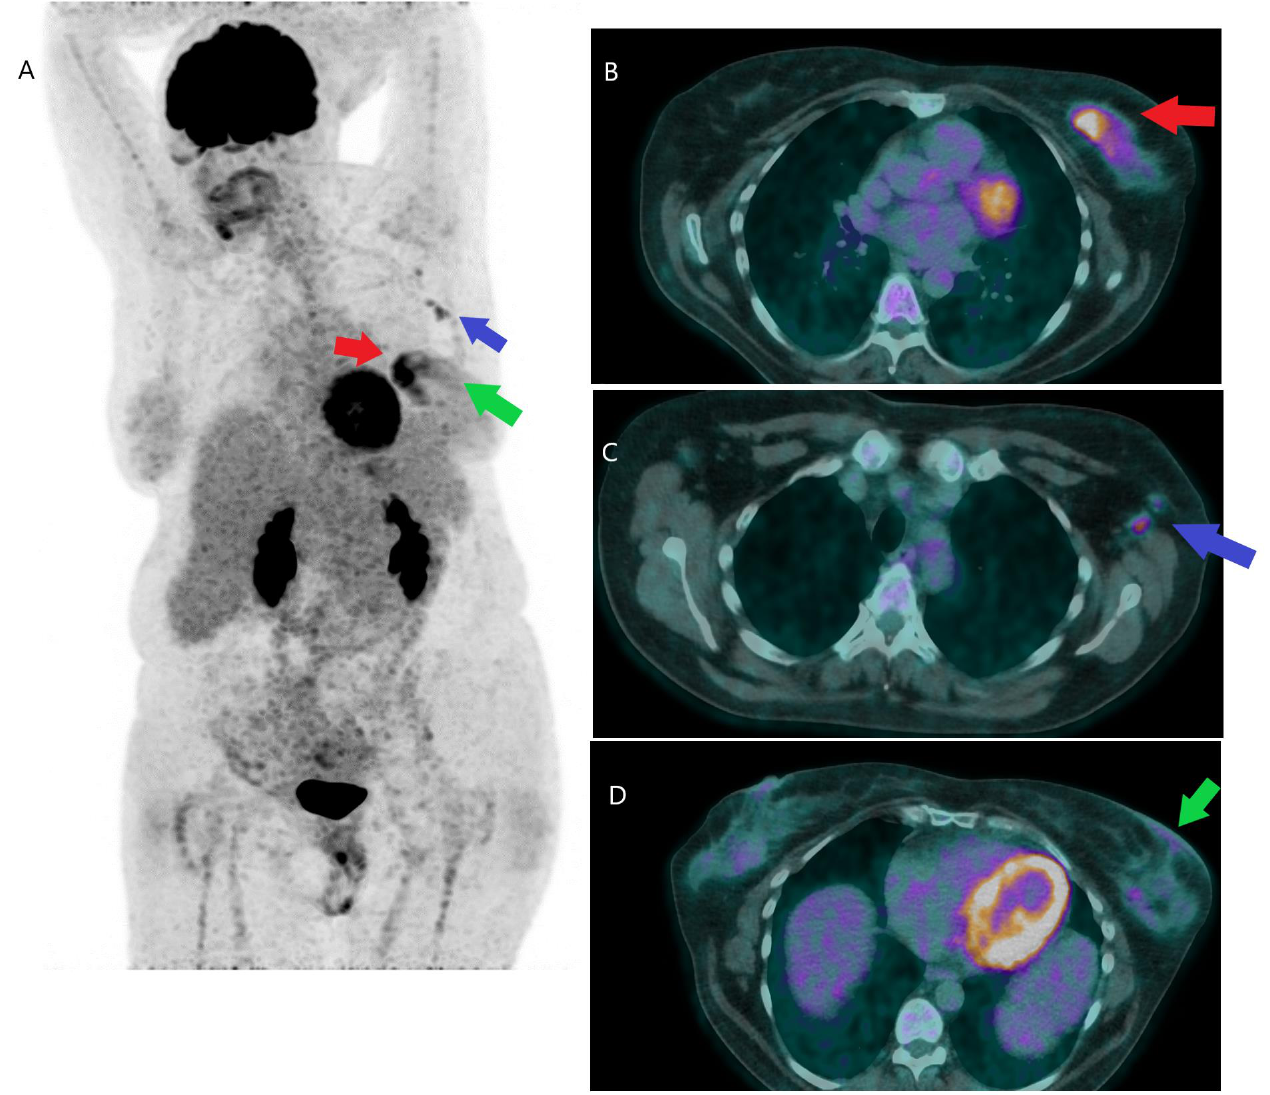
Figure 1. FDG PET/CT in initial staging. A 52-year-old woman with a newly diagnosed inflammatory left breast invasive ductal carcinoma of 29 mm, was referred for initial staging with FDGPET/CT. The PET/CT MIP image ( A ) shows the primary cancer (red arrow), axillary adenopathies (violet arrow), and cutaneous involvement (green arrow). Image ( B ) (fusion image, trans-axial view) shows the primary lesion of the left breast (red arrow). Image ( C ) (fusion image, trans-axial view) shows the axillary lymph node involvement of Berg’s level I (violet arrow). Image ( D ) (fusion image, trans-axial view) shows the cutaneous involvement (green